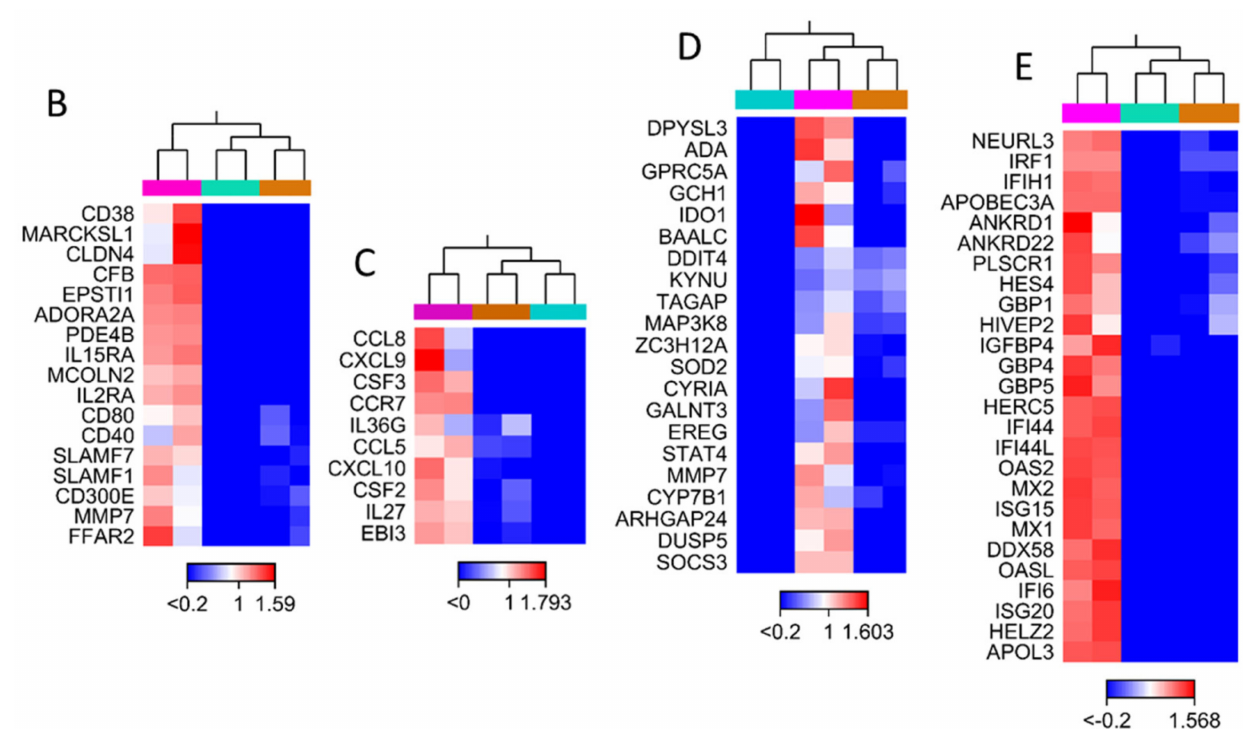
Figure 7. SlpA engages human dendritic cells to trigger differential gene expression. Human dendritic cells were stimulated with R110, WT Lactococcus lactis strain, or left unstimulated. Total isolated RNA were sequenced using Novaseq at a commercial site. The transcriptomic data were analyzed using CLC Genomic Workbench v. 20. Differential expression genes were determined with a selection threshold of p -value ≤ 0.05 and log2-fold change ≥ 1. Duplicate samples were used for each condition. ( A ) Ven diagram showing the numbers of differentially expressed genes at different stimulation. ( B – E ) Heat maps showing the differential gene expression of cell surface receptors, ( B ) cytokines and chemokines, ( C ) immunomodulating enzymes, ( D ) and interferon-related genes ( E ) in response to R110.